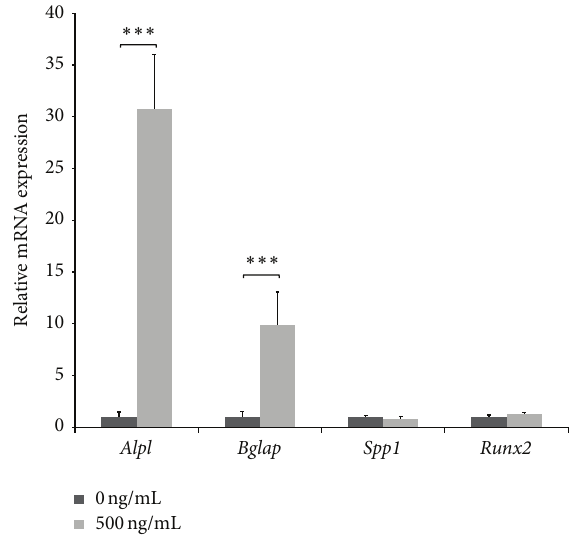
Figure 1: Illustration of the murine coculture model simulating bone-tendon integration in vitro.